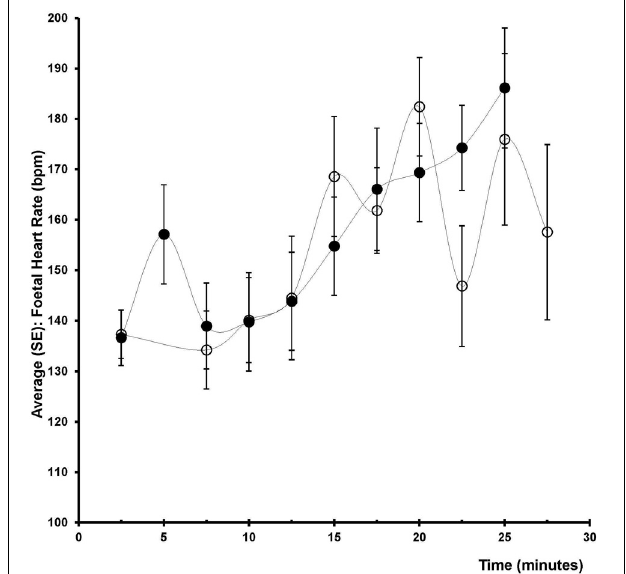
FIGURE 4 | Foetal heart rate. Change in fetal heart rate (bpm) after induction (2.5–5min), before surgery (7.5–17.5min), after delivery (12.5–27.5min) in two groups of 12 patients undergoing spinal anesthesia for caesarean section and receiving either phenylephrine (open circles) or ephedrine (black